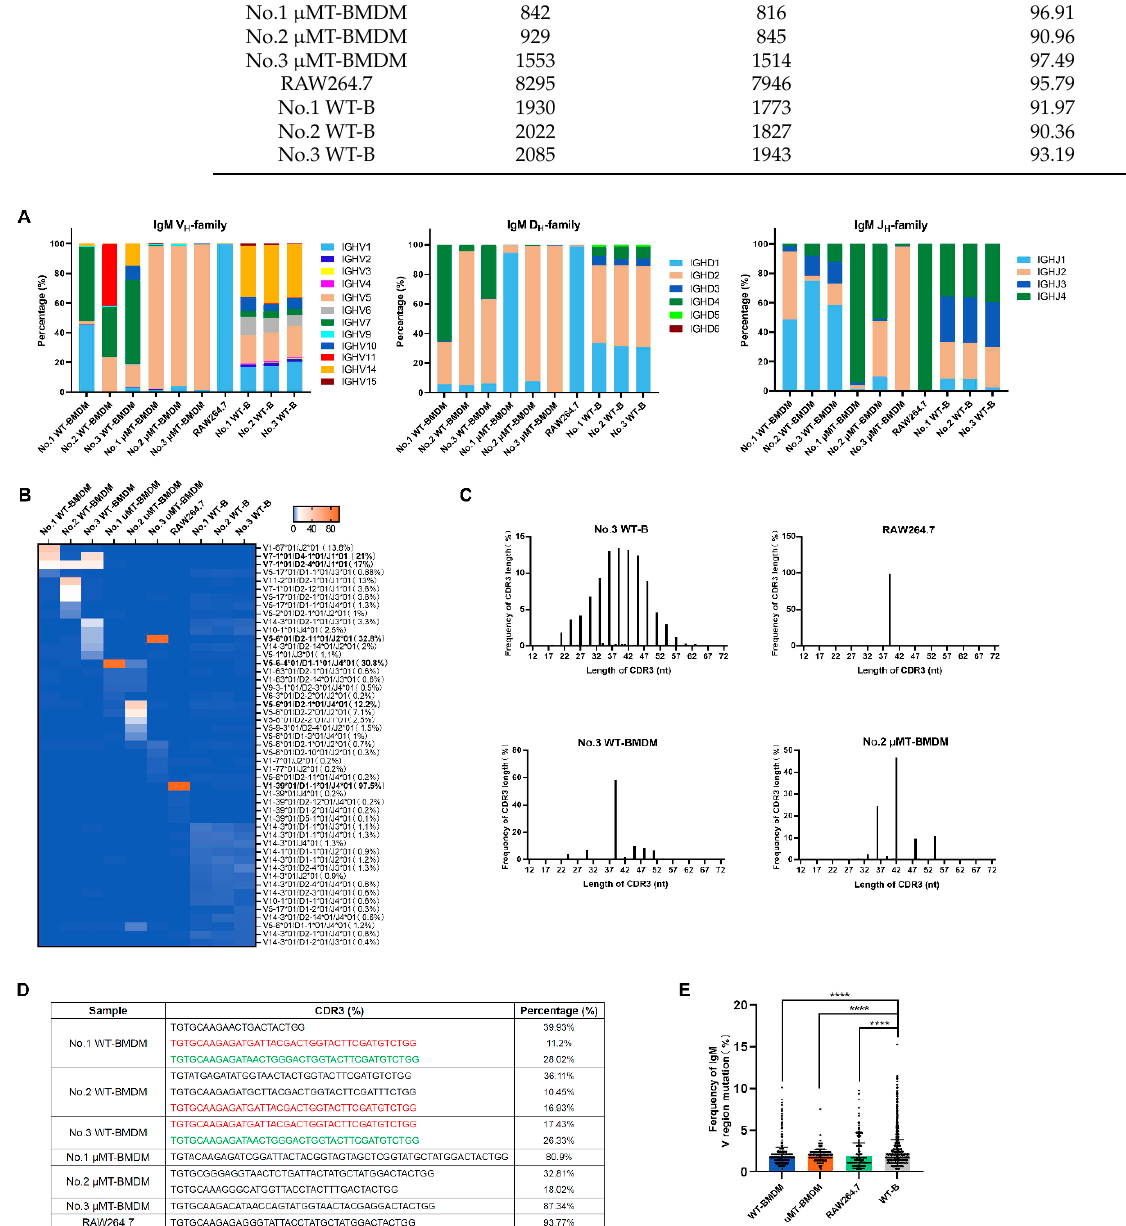
Figure 2. Repertoire features of IgM variable region sequences from murine macrophages. ( A ) IgM V H , D H , and J H gene family usage profiles of BMDMs from WT and μ MT mice and RAW264.7 cells compared with B cells. The frequency (%) of V H family genes (left), D H family genes (middle), and J H family genes (right) expressed by macrophages and B cells, respectively, from three different individuals, demonstrated the IgM derived from macrophages differed significantly from that of the B-derived IgM. ( B ) Distribution of restricted V H DJ H rearrangement patterns of BMDMs from WT and μ MT mice and RAW264.7 cells compared with B cells. The percentage of different rearrangement patterns is given in parentheses. ( C ) Length variant analysis of CDR3 demonstrates the constitutive expression of individual-specific IgM variable heavy-chain repertoires in B cells. Non-normalized CDR3 length spectra typing for BMDMs from WT and μ MT mice and RAW264.7 cells. ( D ) Sequential CDR3 repertoire analyses in BMDMs from WT and μ MT mice and RAW264.7 cells. The common sequences were colored in red or green consistently. ( E ) Mutation frequencies of IgM variable region in BMDMs from WT and μ MT mice and RAW264.7 cells compared with B cells. Abundance was first normalized by region length and then by total number of cleaned, productive reads in each respective data set, and multiplied by 100 to attain percent abundance. **** p < 0.0001.